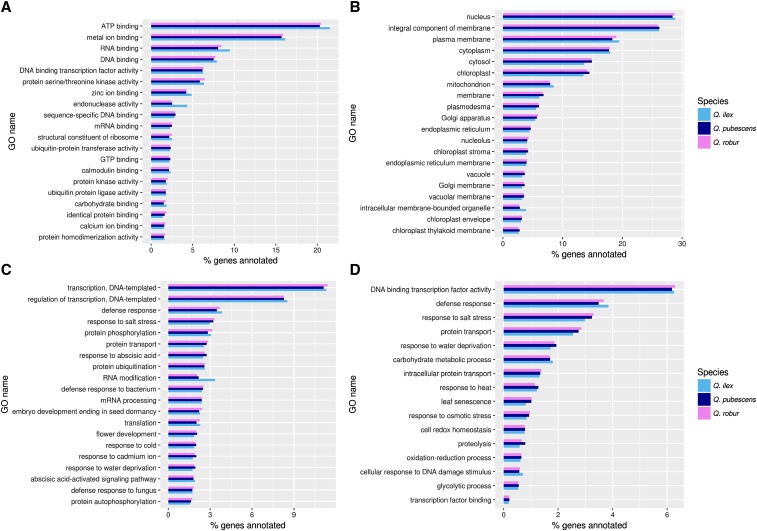
GO term distribution. 20 mostly assigned GO terms in the category (A) molecular function, (B) cellular function, (C) biological function and (D) selected drought stress related GO terms for Q. robur in comparison to Q. pubescens and Q. ilex in % of annotations relative to all GO annotated genes in that species.